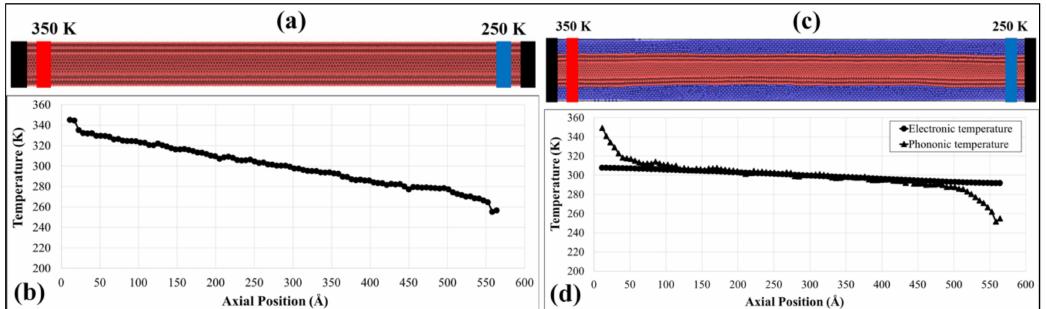
Figure 1. ( a ) Atomic model of a 3WCNT with heat baths and fixed ends, and ( b ) temperature profile along the axis of the 3WCNT due to the heat baths. ( c ) Atomic model of a (1 nm) Ni-coated 3WCNT with heat baths and fixed ends, and ( d ) phononic and electronic temperature profiles along the axis of the model due to the heat